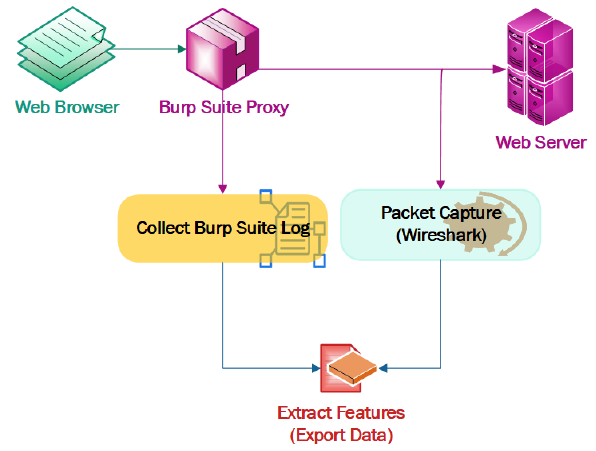
Figure 6. Dataset generation approach for DDoS, XSS, and SQL